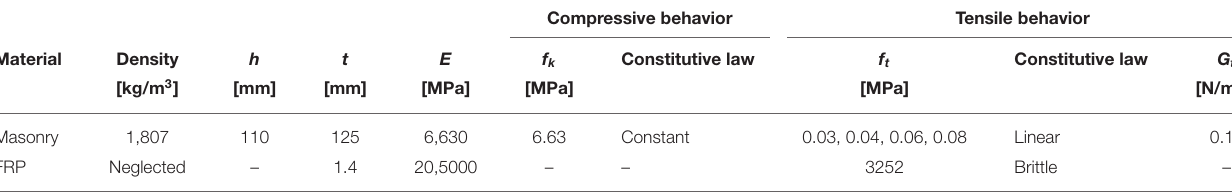
TABLE 2 | Masonry and FRP mechanical properties.